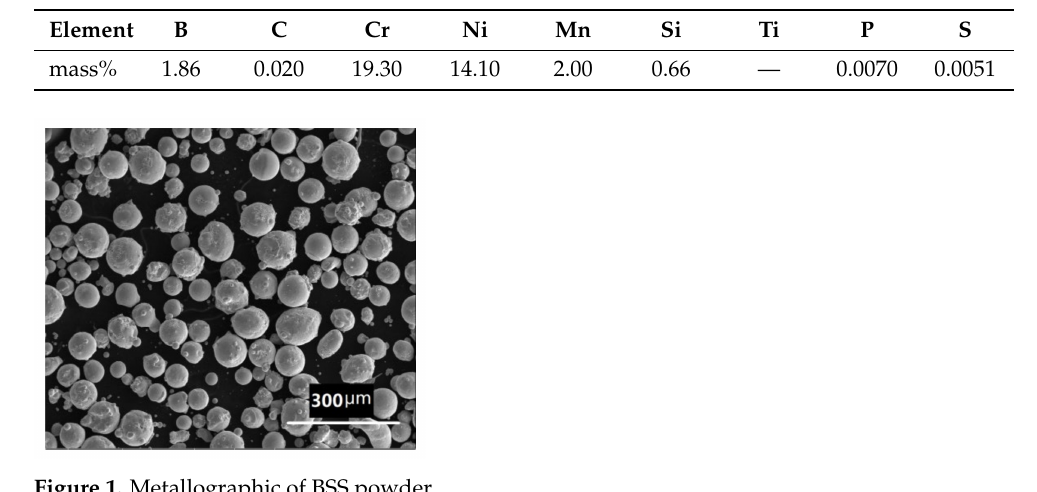
Table 1. Chemical composition of investigated alloys in mass%.